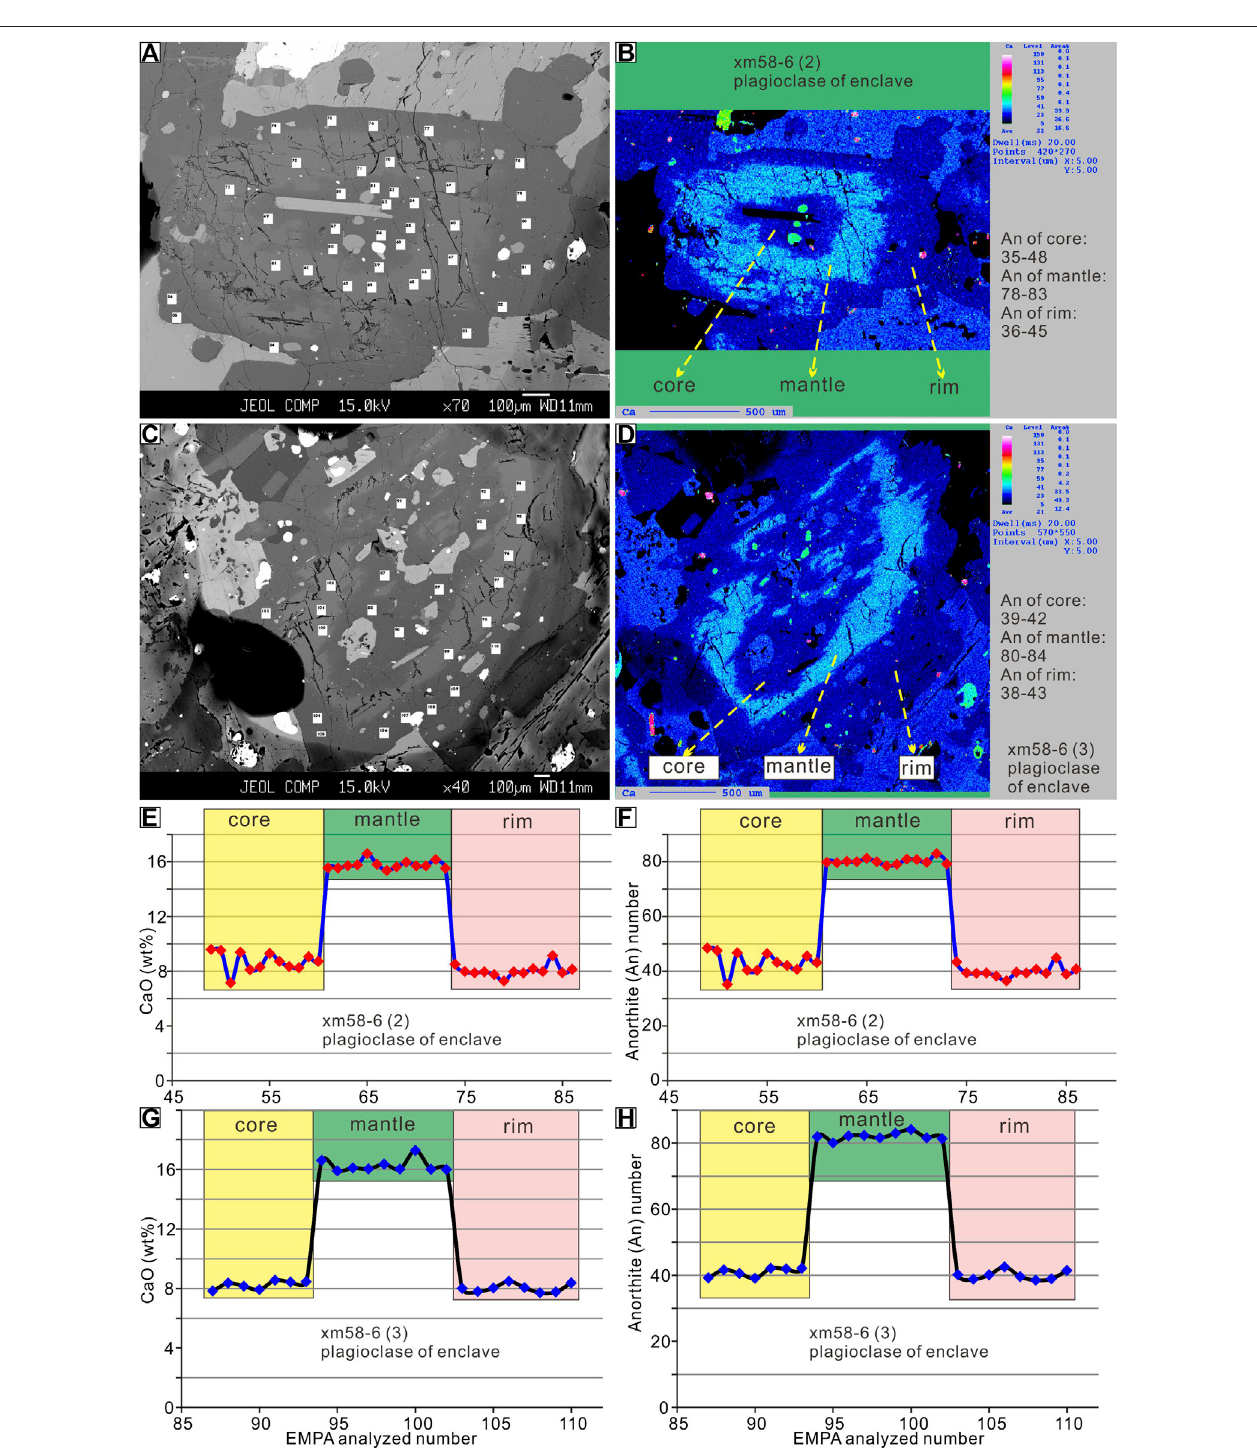
FIGURE 9 | Photomicrographs of plagioclase phenocrysts enclosed within the enclaves. (A, C) Backscattered-electron images (BSEs) for these plagioclases, revealing discontinuous zoning. (B, D) Electron microprobe analyses (EMPA) compositional mapping for these plagioclase phenocrysts. (E – H) CaO contents and anorthite (An) number plotting.